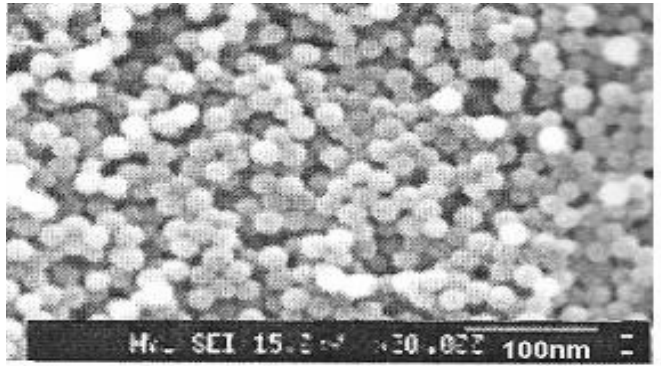
Figure 1. SEM micrograph of SiO